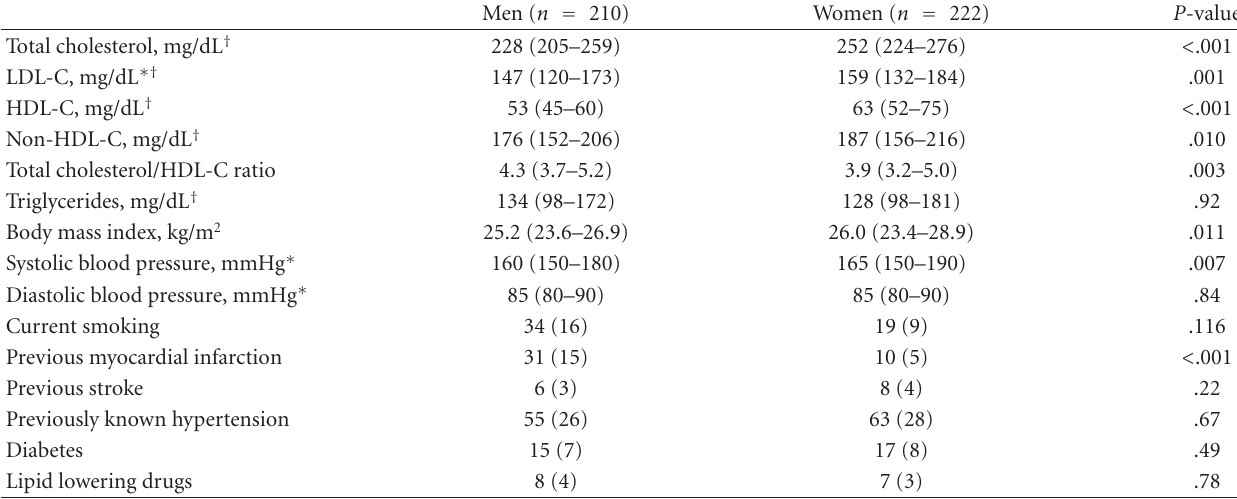
Table 1: Baseline characteristics of the 75-year-old participants. Values are median (interquartile range) and number